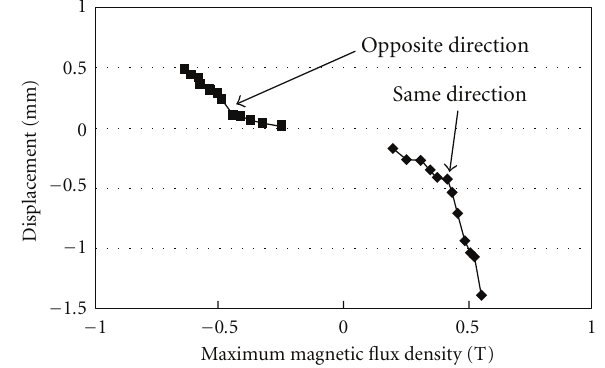
Figure 18: Displacement of levitating